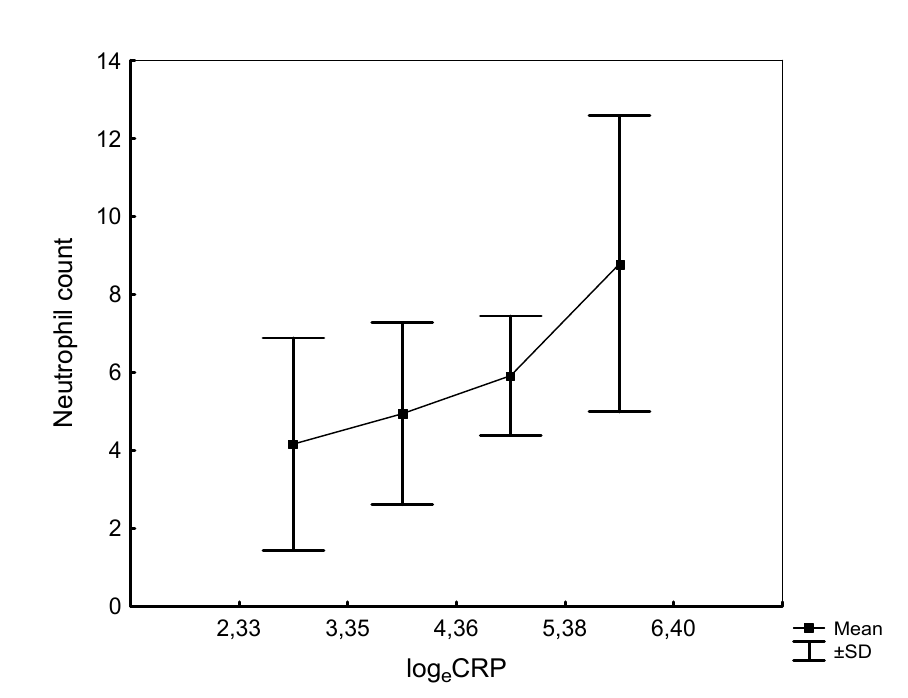
Fig. 3 Relationship between neutrophil count and CRP plasma concentration (log e - transformed) in AP patients on the 4 th day after admission.